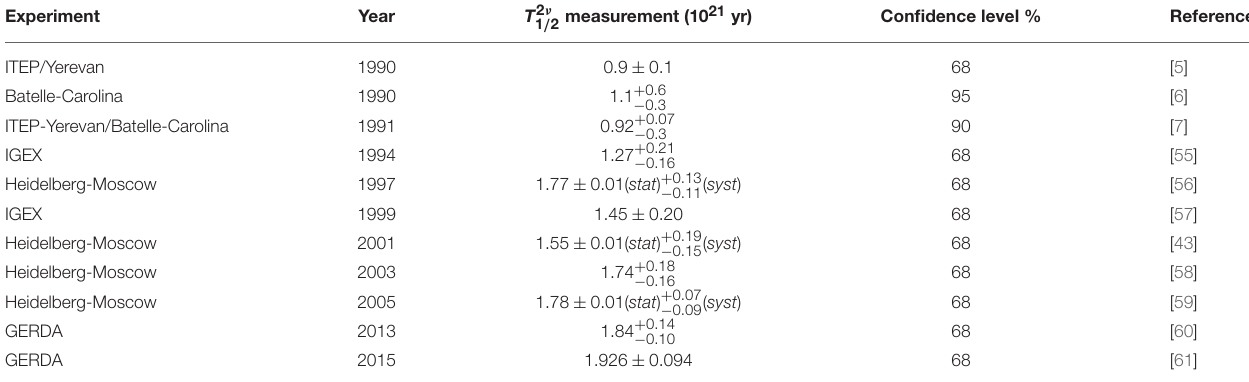
TABLE 3 | Results of 76 Ge 2 νββ